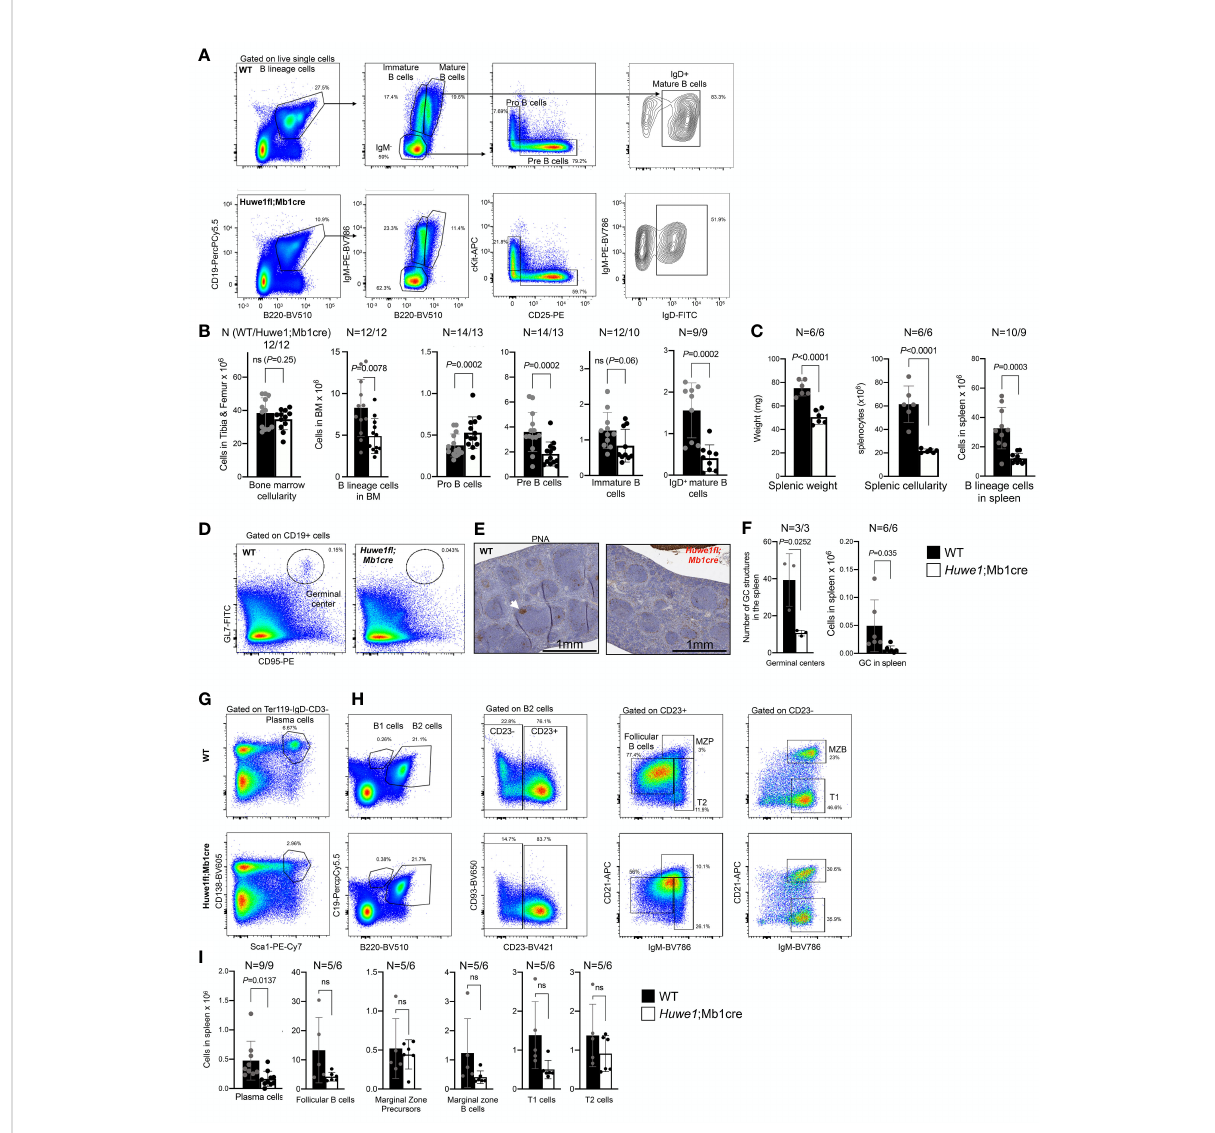
FIGURE 1 Impaired B-cell development in the bone marrow of Huwe1 ;Mb1cre mice. (A) Representative fl ow cytometry gating strategy to assess B-cell development in the bone marrow of wildtype (WT) mice (top) and Huwe1 ;Mb1cre (bottom) mice. Left panels show the B-cell percentages in the nucleated cell compartment, middle panels show the IgM-negative, mature, and immature B cells, and the right panels depict the pro-B cells and pre-B cells. (B) Absolute numbers of cell populations indicated in (A) in the bone marrow. Mean ± SD is shown. N for WT (left) and Huwe1 ; Mb1cre is depicted above the graph. Black bars depict WT mice, white bars depict Huwe1 ;Mb1cre mice. (C) Splenic weight, cellularity, and B lineage cells (CD19 + B220 + ) in the spleen. (D) Flow cytometry gating strategy of spontaneous germinal centers in the spleen. Percentages of GL7+ CD95+ GC B cells are indicated. (E) Peanut agglutinin (PNA) immunohistochemistry staining in the spleen. Magni fi cation is 20X. (F) Germinal centers in the spleen as identi fi ed by counting PNA+ GCs in IHC slides (left), and by fl ow cytometry staining for GL7 and CD95 (right). (G, H) Flow cytometry gating strategy for plasma cells in the spleen and splenic follicular B cells, marginal zone progenitors (MZP) and transitional 1 (T1) and 2 (T2) B-cell subsets (H) . (I) Absolute numbers of subsets as indicated in (G, H) , bar graphs depict means ± SD. P -values were calculated using an unpaired t-test with Welch correction. ns, not signi fi